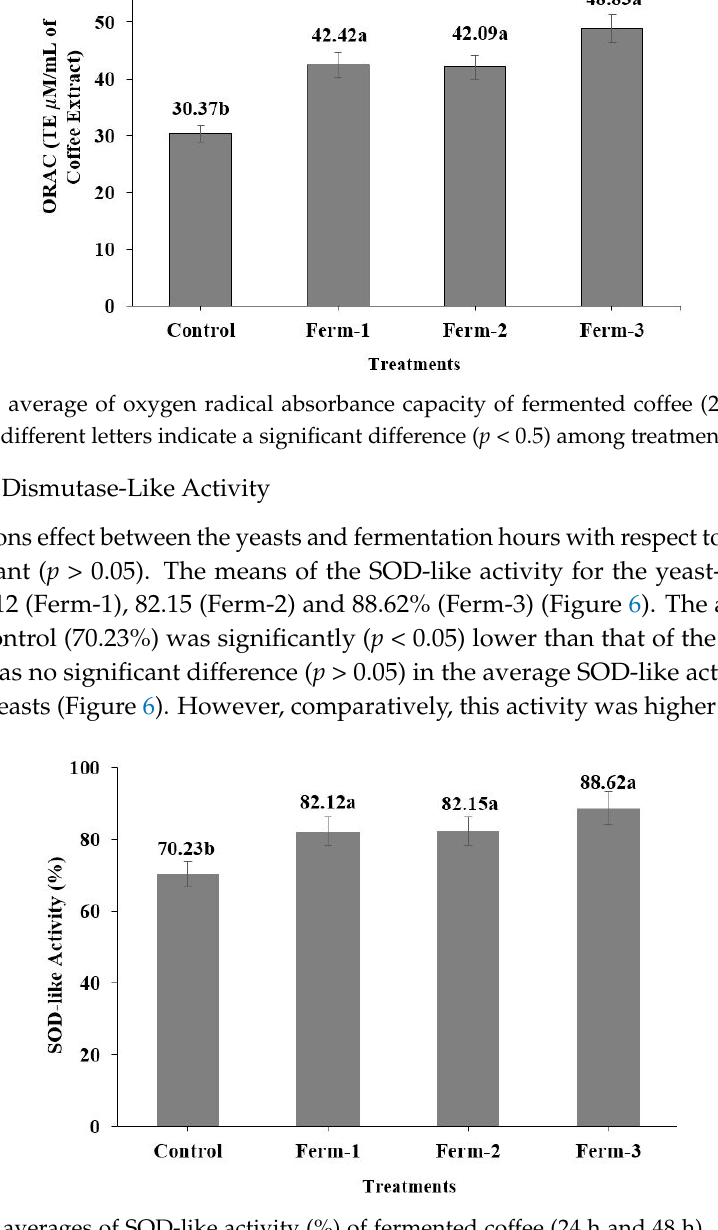
Figure 6. The averages of SOD-like activity (%) of fermented coffee (24 h and 48 h). The bars with different letters indicate a significant difference ( p < 0.5) among treatments.